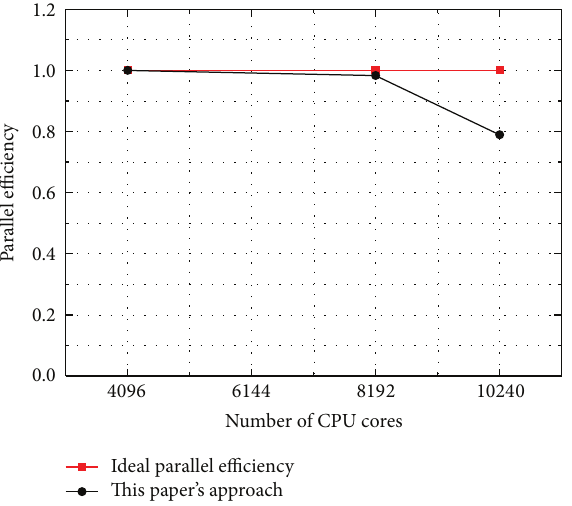
Figure 9: The parallel efficiency of 4096 ∼ 10240